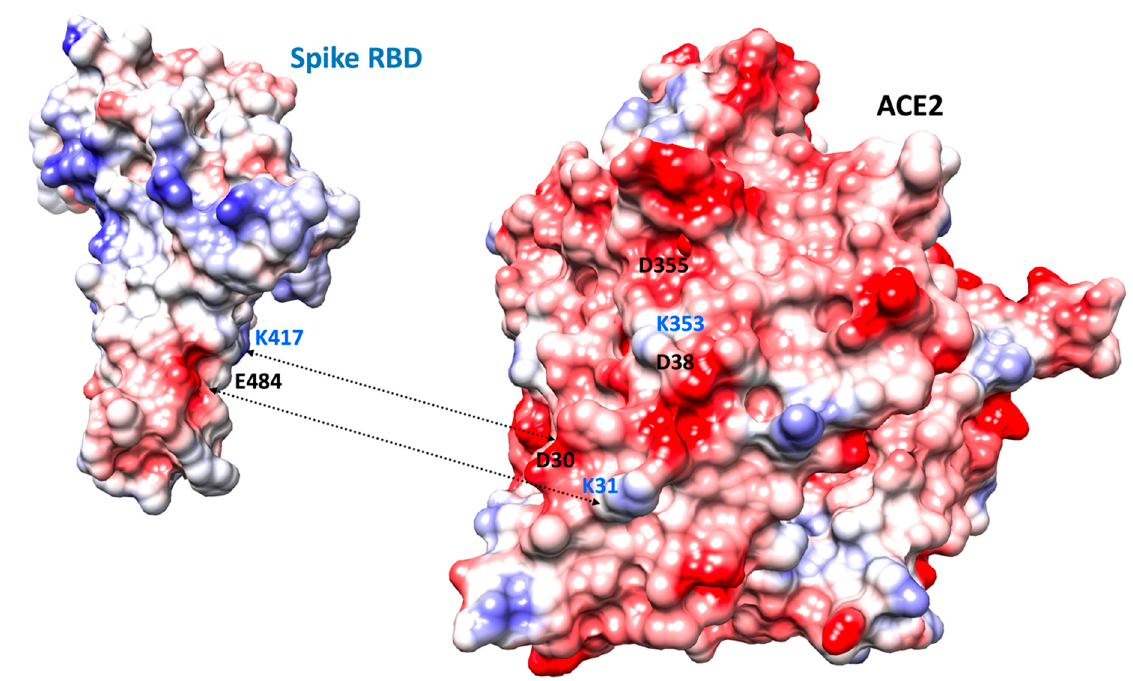
Figure 6. Molecular surface of the Spike and ACE2 proteins color-coded according to electrostatic potentials. The potentials were computed using Coulomb’s law. The orientation is slightly modified as compared to Figure 5 and the molecules were spread apart so as to better see the interface. Some residues are labelled for orientation. The color gradient runs from electronegative values ( − 10 kcal/(mol.e) in red), to more neutral (white) to electropositive (+10 kcal/(mol.e) in blue). The interface area on ACE2 tends to be electronegative while for the Spike protein, we observe two regions, one electronegative and one electropositive, separated by a more neutral zone.